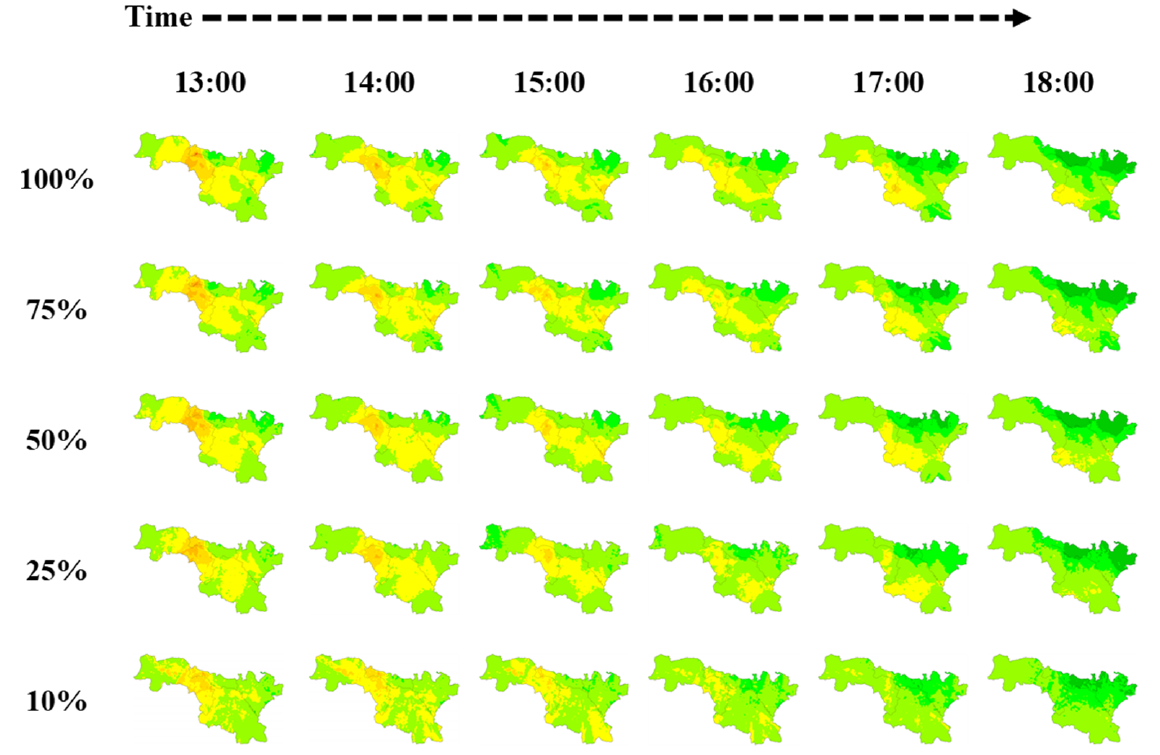
Figure 7. Citywide PM 2.5 pollution mapping results on 8 February 2022 by different station densities.